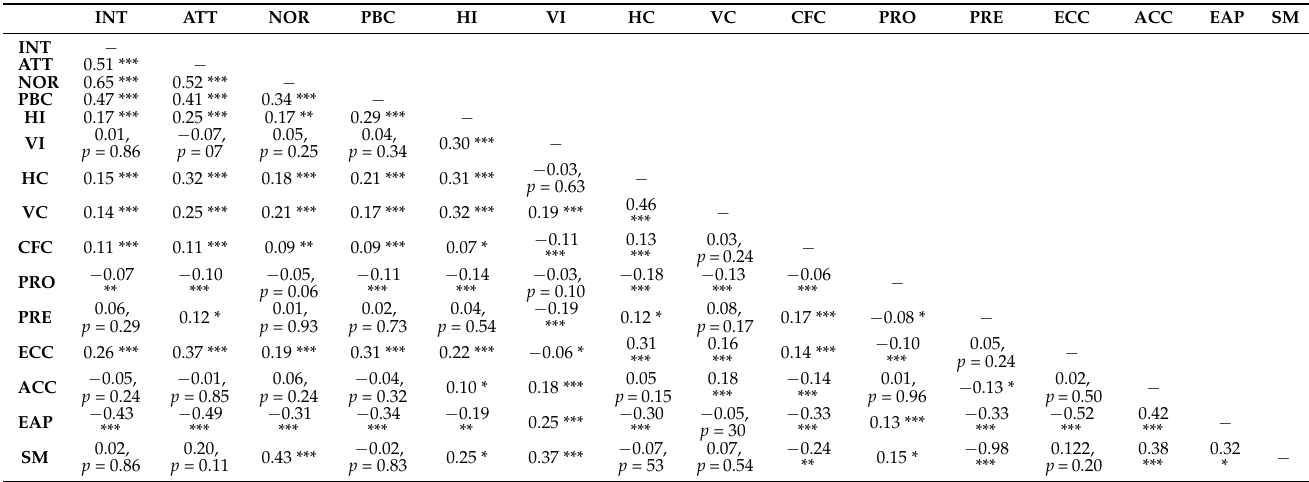
Table 2. Measurement covariance